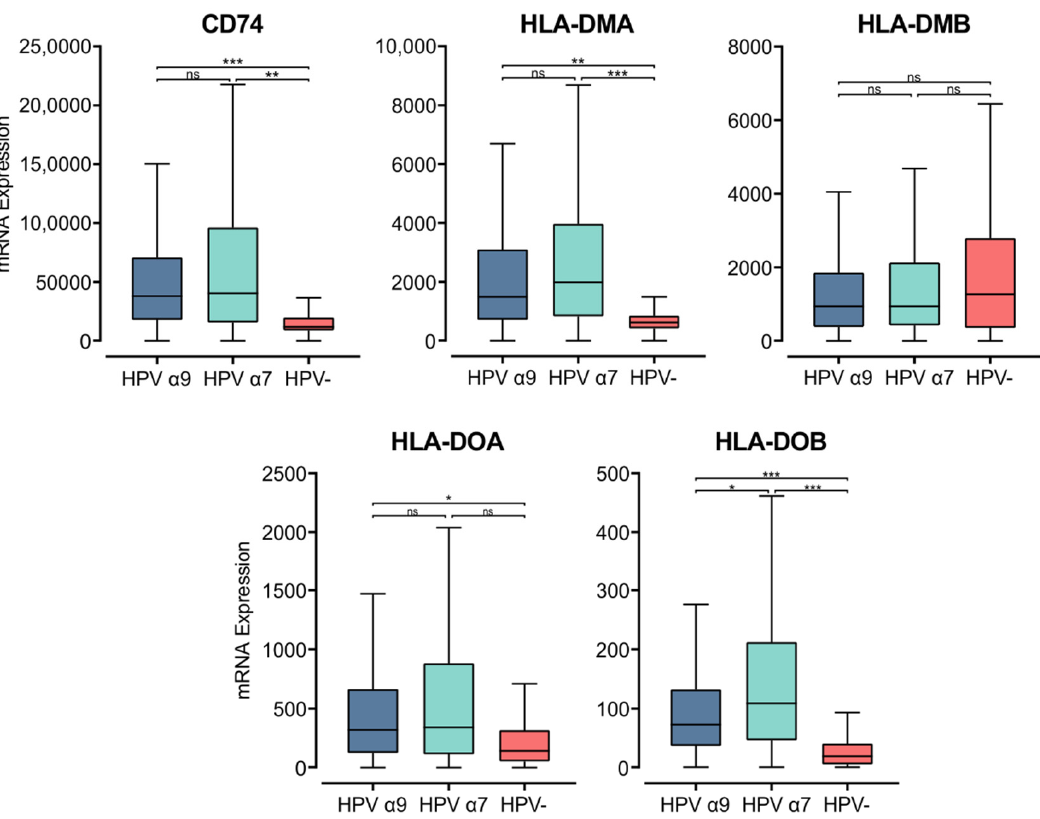
Figure 2. Expression of invariant chain ( CD74 ) and MHC class II-like genes in CC stratified by HPV+ ( α 9 or α 7) and HPV − status. Normalized RNA-seq data were extracted from the CC cohort of the TCGA database. *** p ≤ 0.001, ** p ≤ 0.01, * p ≤ 0.05, ns (not significant).